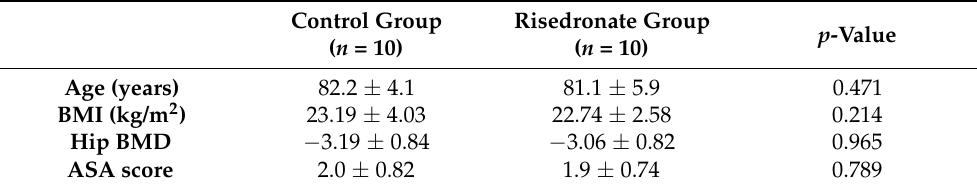
Table 2. Comparison of the control group and risedronate group.